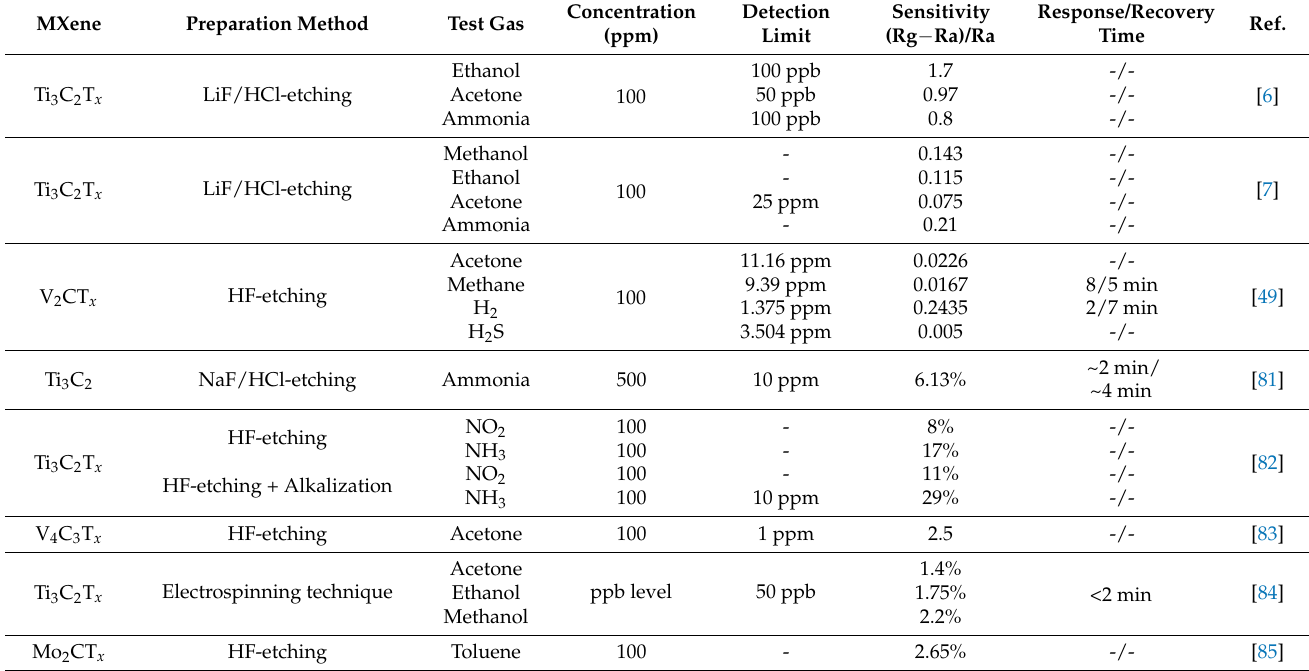
Table 1. List of the selected sensors prepared using pure MXene